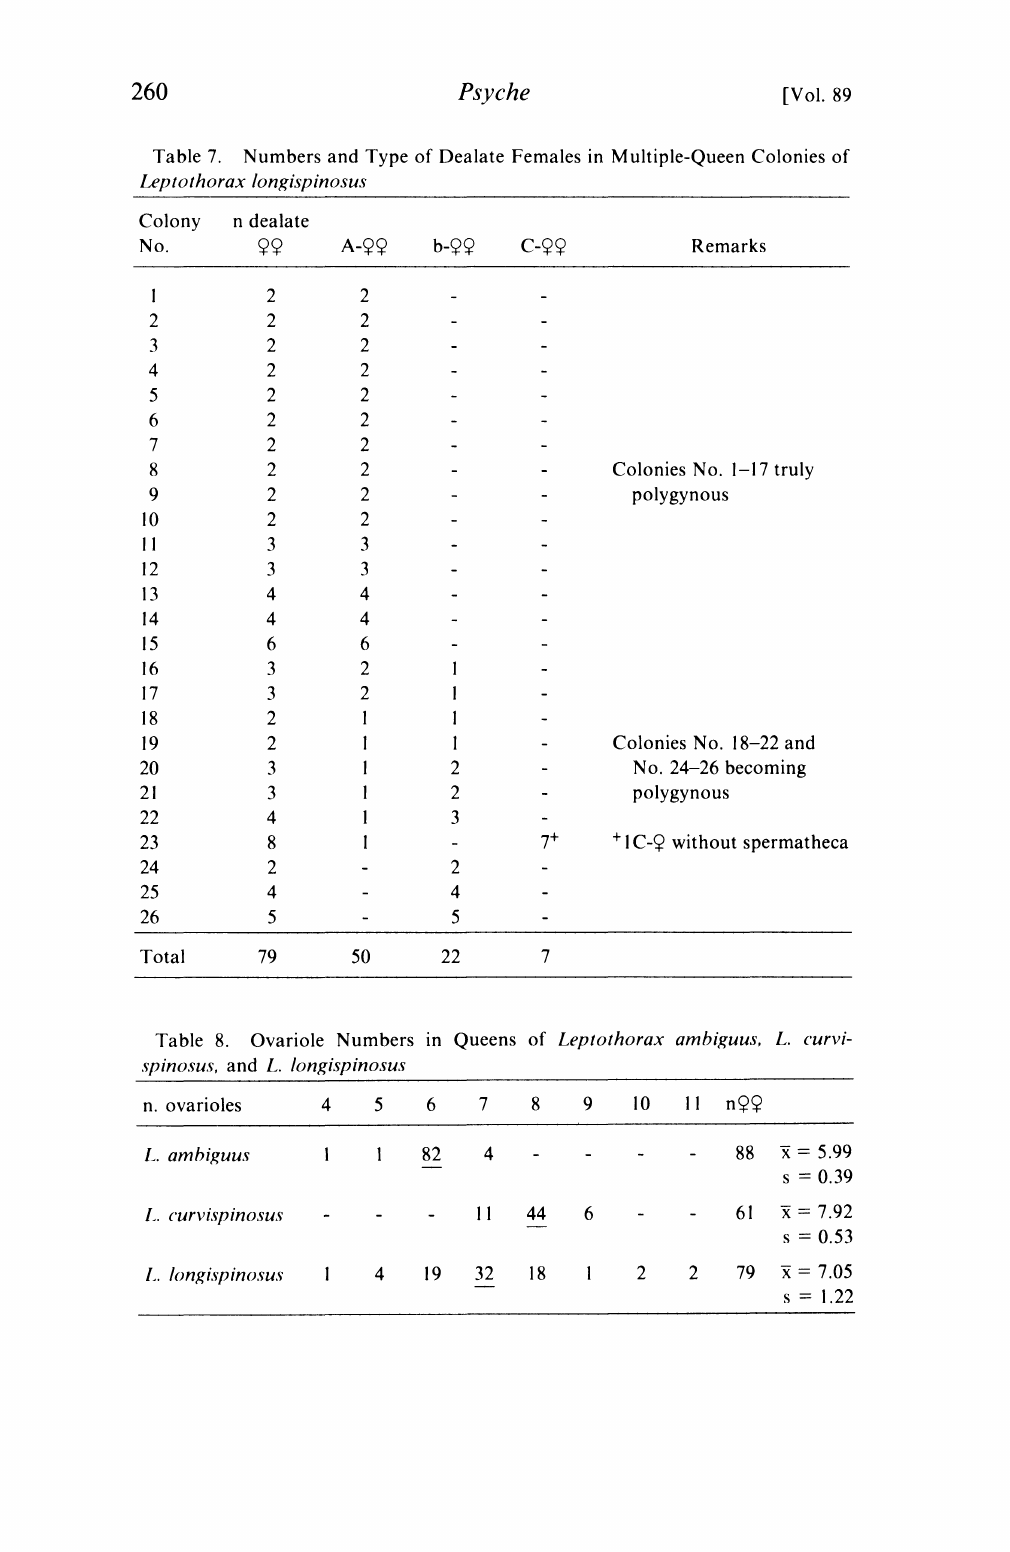
Table 7. Numbers and Type of Dealate Females in Multiple-Queen Colonies of Leptothorax longispinosus Colony